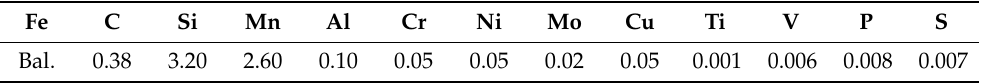
Table 1. Chemical composition (wt.%) of the Investigated